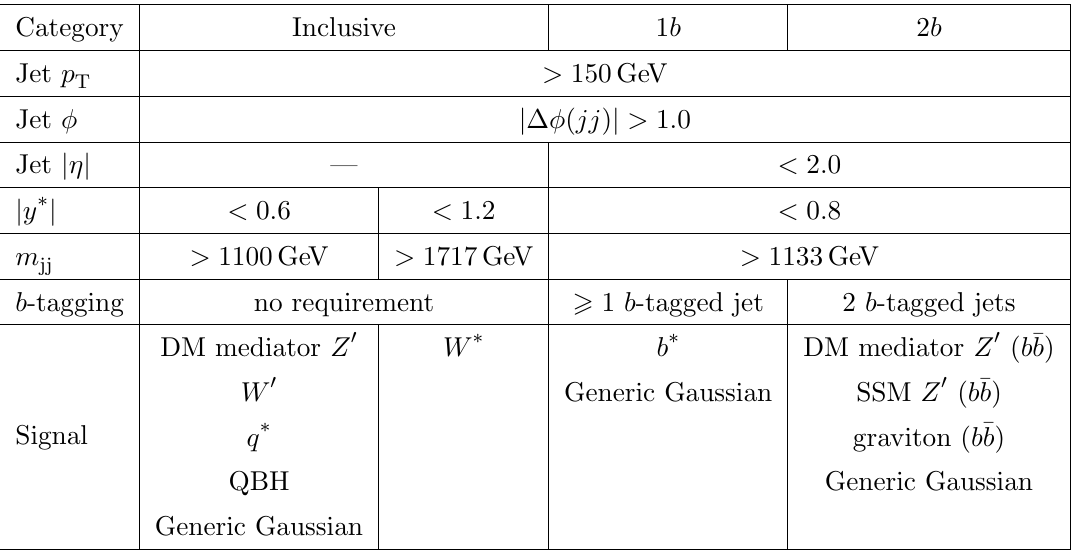
enter in the event selection. The exact values T